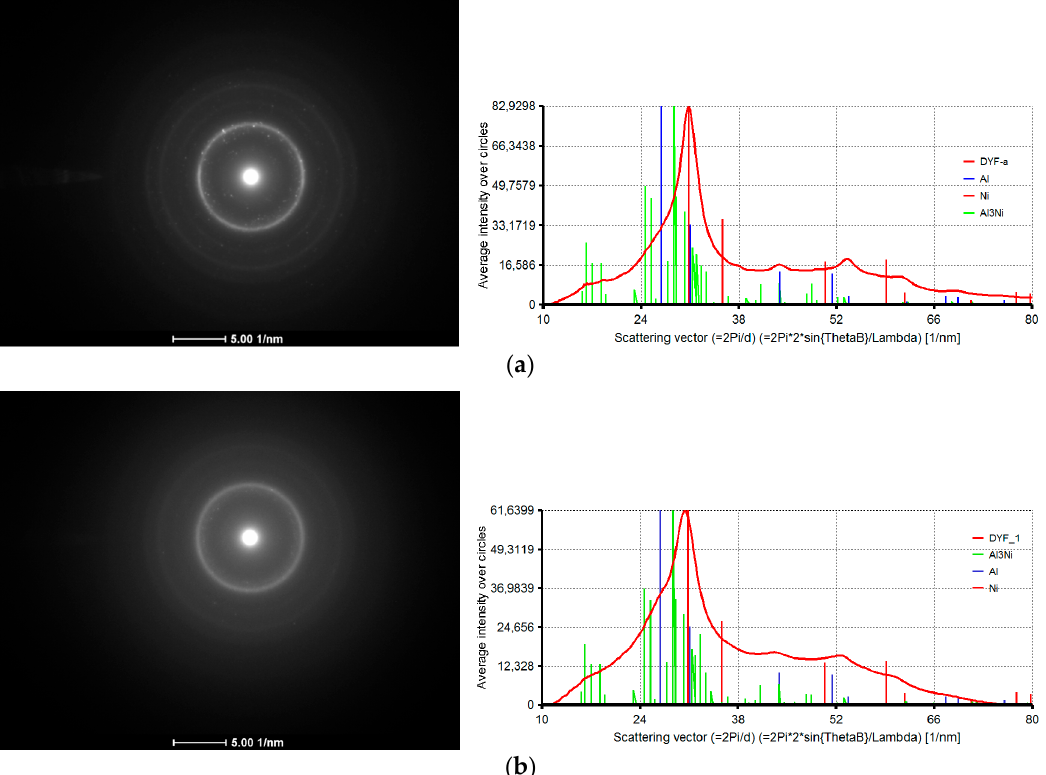
Figure 5. SAD patterns of Ni/Al multilayer thin films deposited onto W wires and respective diffraction spectra. ( a ) Middle and ( b ) bottom part of the wire.